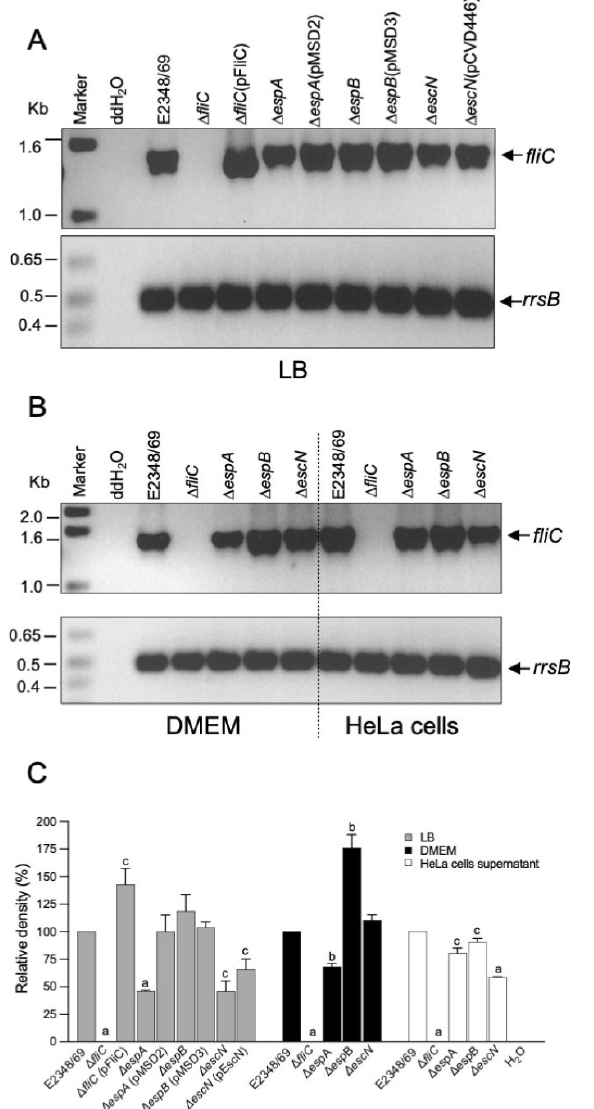
Figure 4. Transcription analysis of fliC in the different EPEC strains. ( A , B ) RT-PCR to determine expression of fliC in the indicated strains after growth in LB, DMEM, and in the presence of epithelial cells. ( C ) Densitometric analysis derived from the mRNA agarose gel electrophoresis ( A ) and ( B ) showing quantitative fliC expression in EPEC E2348/69 and its derivative mutants. The quantitative data are the mean of three different measurements. Letters a, b, and c show statistical significance of the mutants tested with respect to E2348/69 grown in each condition (one-sample t test), a = p < 0.001; b = p < 0.01; c = p < 0.05. The Δ fliC mutant was used as the negative control and detection of rrsB was used as a loading